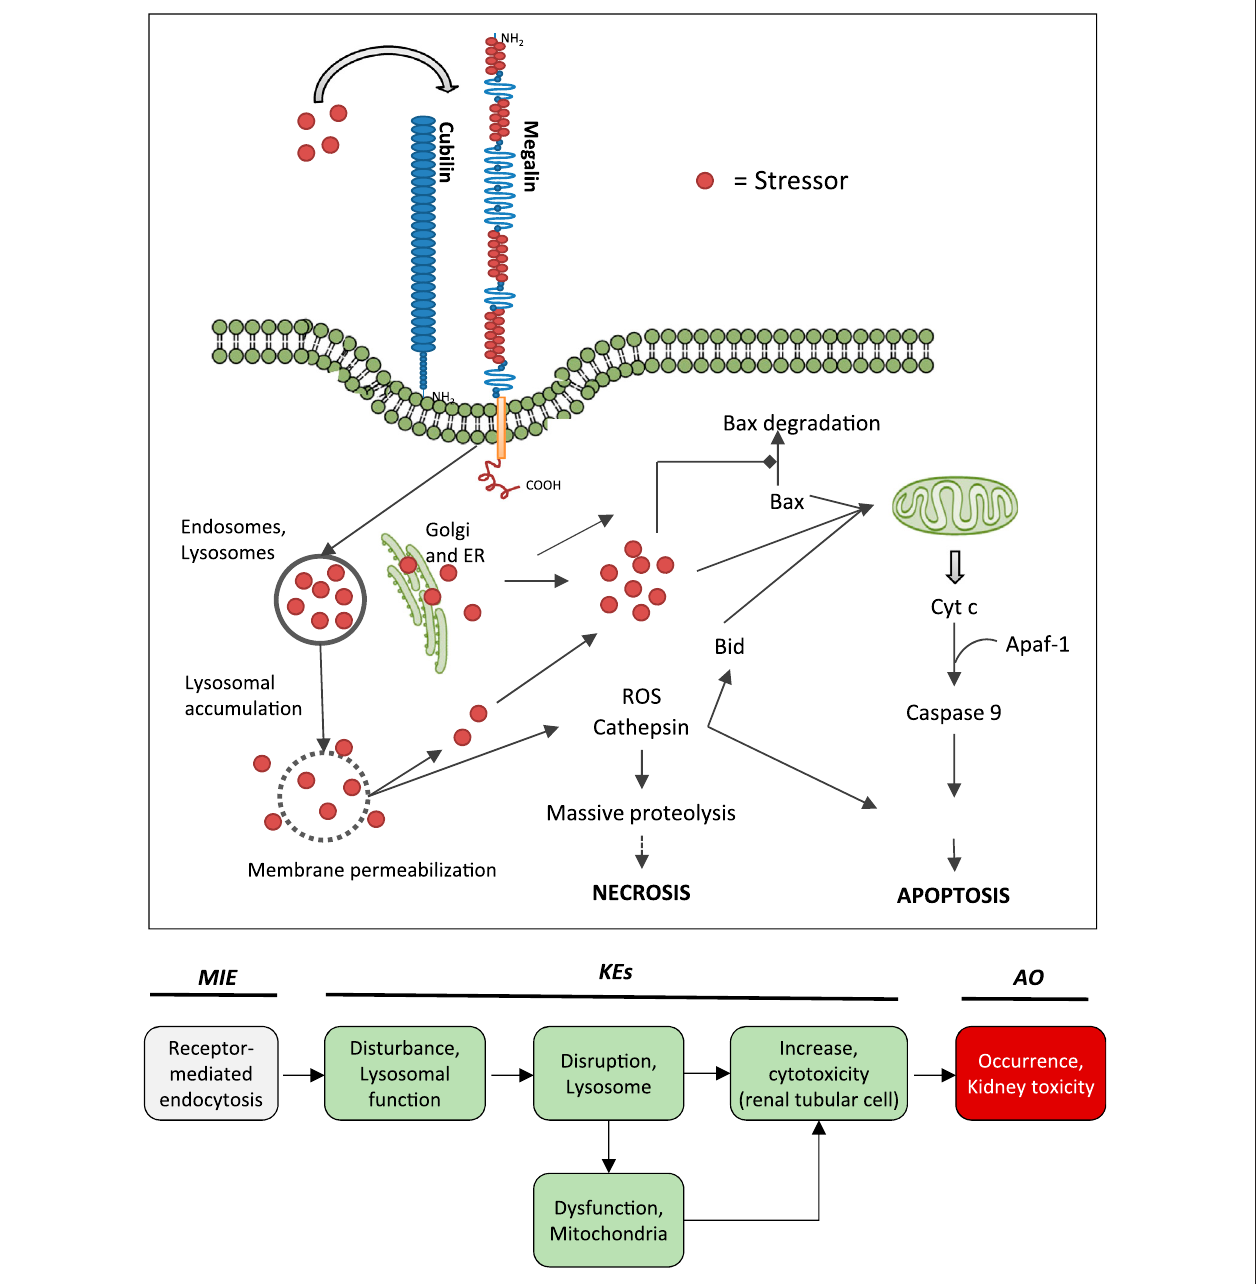
FIGURE5| Uptakeofpolybasicdrugsandcompoundswithpeptidicstructureviamultiligand,endocyticreceptors(megalin,cubilin)expressedatthebrush-boarderofrenal tubulecells.Endocytosedcompoundsmayaccumulatewithinlysosomes,leadingtolysosomalswellinganddisruptionoflysosomes.Releaseofreactiveoxygenspecies,cytotoxic lysosomal enzymes and possibly also endocytosed compounds may trigger cell death via necrosis or apoptosis. This may occur as a direct consequence (e.g., via massive proteolysis) or secondary to mitochondrial dysfunction. Adverse outcome pathway of receptor mediated endocytosis and lysosomal overload leading to kidney toxicity.